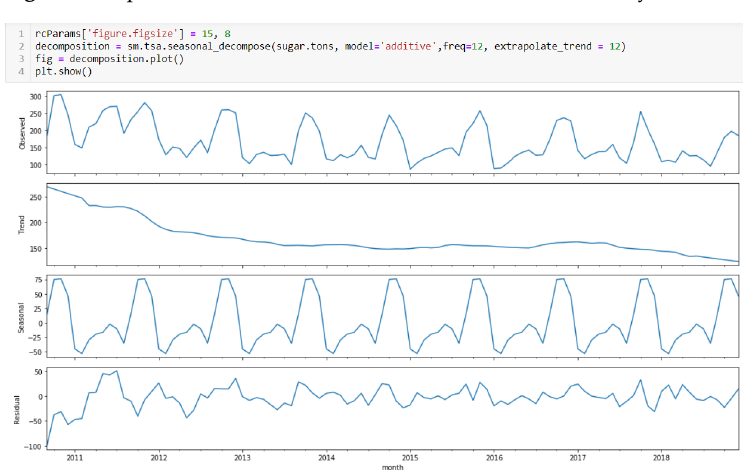
Figure 4. Seasonal-Trend Decomposition Procedure Based on